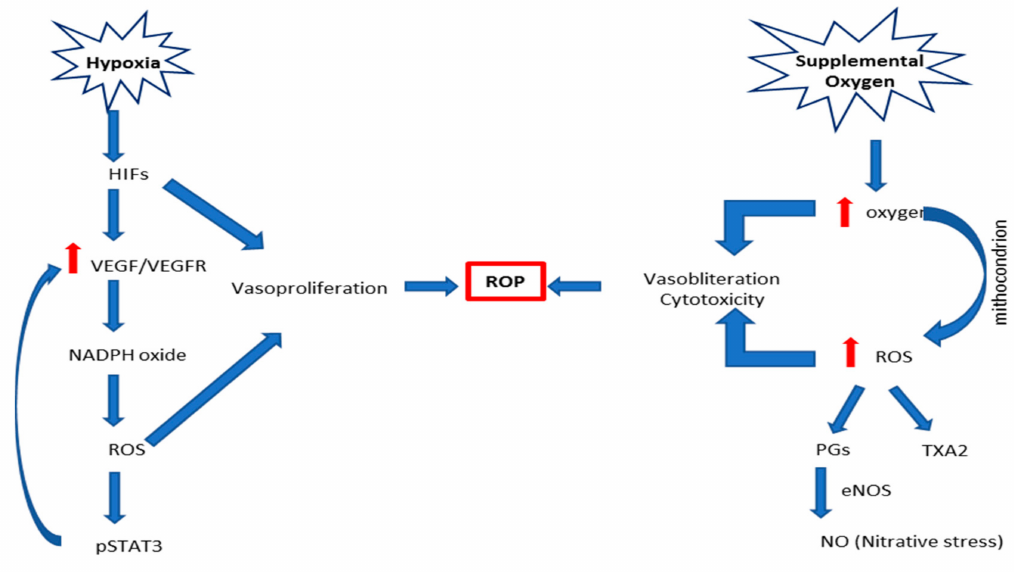
Figure 1. Description of the main known biochemical cascade of events leading to retinopathy of prematurity (ROP). Abbreviations: eNOS, endothelial NO synthase; HIFs, hypoxia-inducible factors; NADPH, dihydronicotinamide-adenine dinucleotide phosphate; NO, nitric oxide; pSTAT3, phosphorylated signal transducer and activator of transcription3; PGs, prostaglandins; ROP, retinopathy of prematurity; TXA2, thromboxane A2; VEGFR, vascular endothelial growth factor